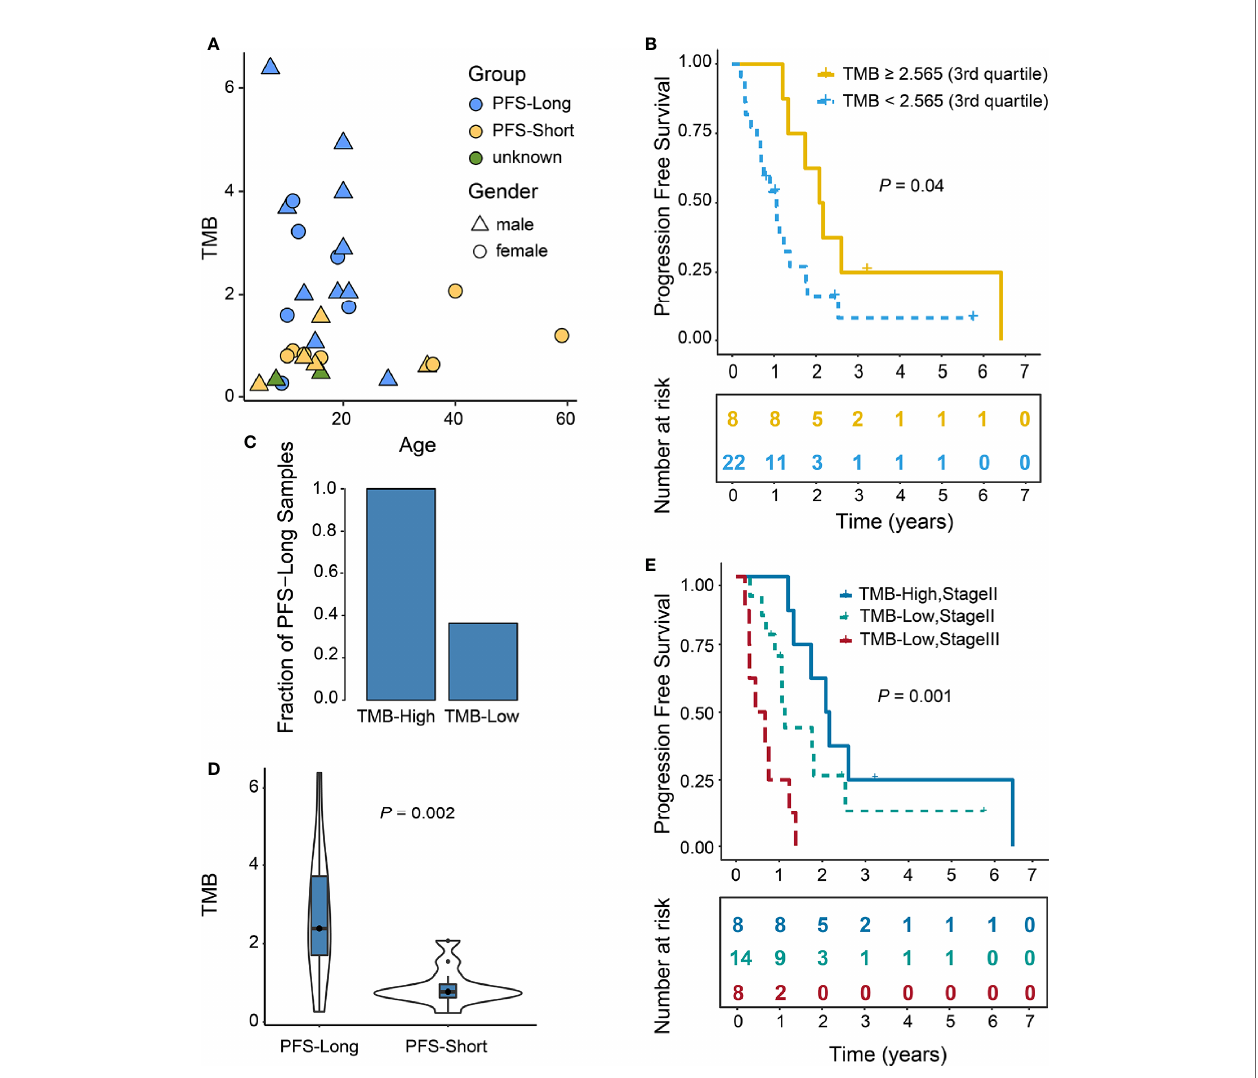
FIGURE 3 | High TMB predicted longer PFS than low TMB. Among 31 patients, 30 patients were included since the clinical information of 1 patient was incomplete. (A) The association of TMB with gender and PFS. Different colors represent relative PFS values. The triangle represents males, and the circle represents females. Patients with PFS>400 days were selected in PFS-Long group (n=16), PFS<400 days selected in PFS-Short group (n=12), two patients with incomplete PFS information selected in unknown group (n=2). (B) Improved PFS in patients with high TMB. TMB was strati fi ed with 3 rd quartile as cutoff=2.565. P value was calculated using log-rank test ( P = 0.04). (C) The percentage of PFS-Long in TMB-High (n=8) and TMB-Low (n=22) groups ( P = 0.003, Fisher ’ s exact test). (D) Violin plot comparing the difference in TMB between PFS-Long (n=16) and PFS-Short (n=12) groups. P value was calculated in two tailed Mann Whitney U test ( P = 0.002). (E) Improved PFS in patients with high TMB and Stage II. Patients were strati fi ed by the combination of Stage and TMB. TMB-High-Stage II (n=8), TMB- High-Stage III (n=0), TMB-Low Stage II (n=14), TMB-Low Stage III (n=8). P-value was calculated using log-rank test ( P =0.001). The numbers in parentheses represent the number of patients in each